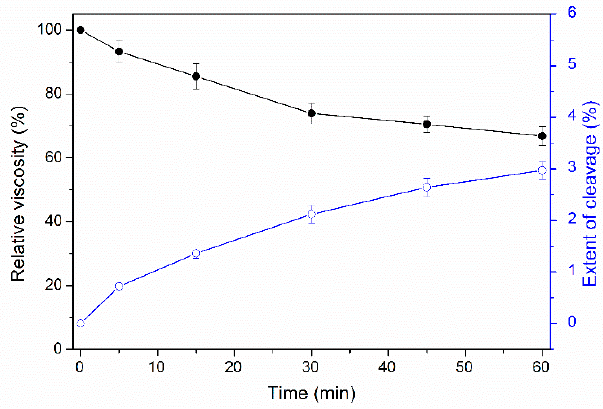
Figure 9. Reduction of PGA viscosity by PpPel10a (- -) and galacturonoside bond cleavage (- -).